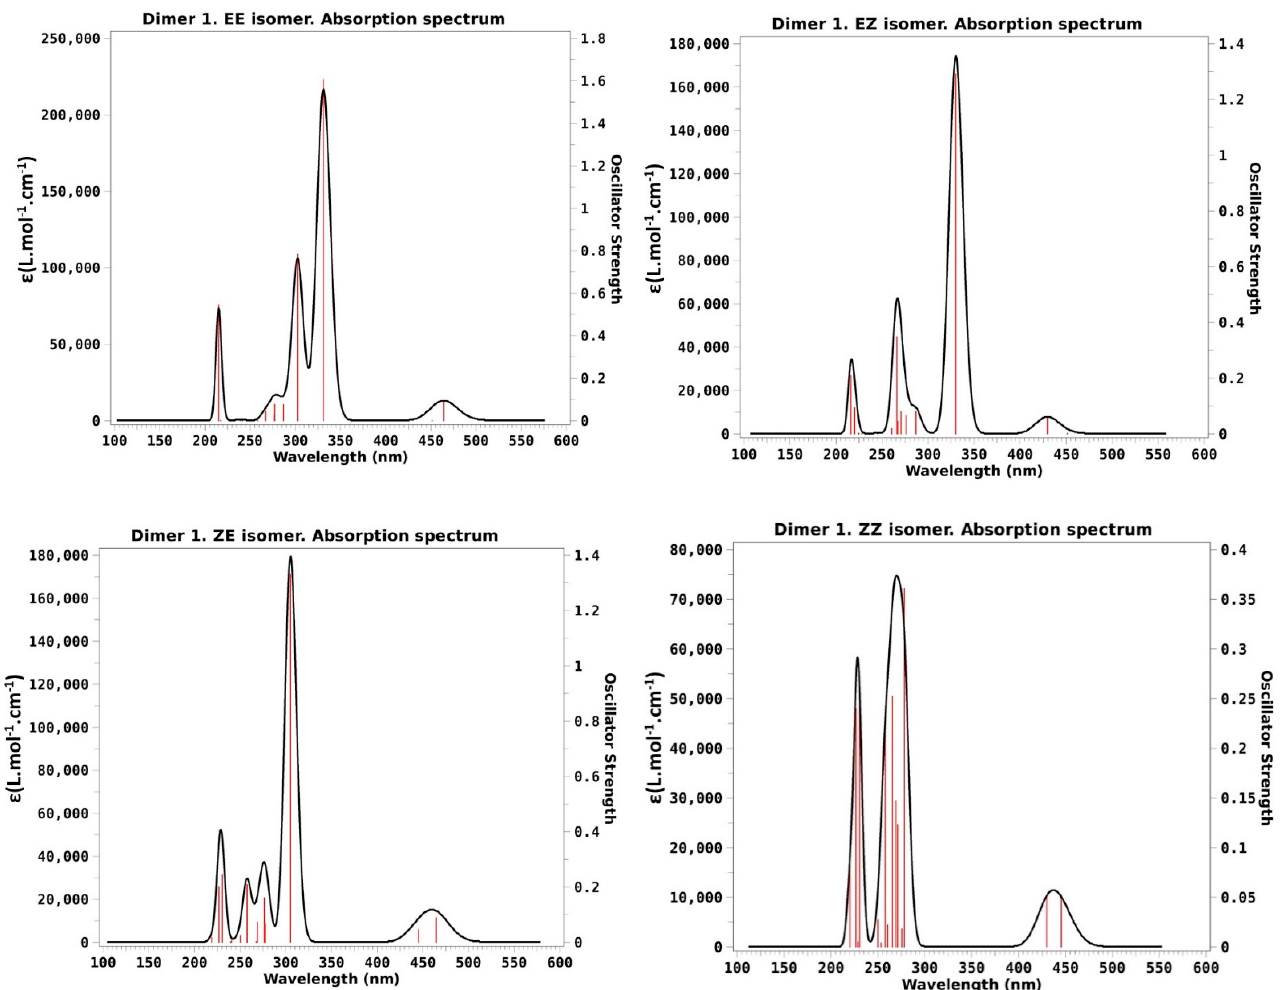
Figure 1. Computed absorption spectra of dimer 1 in acetonitrile at the optimized ground-state geometries of the four stable isomers of dimer 1. Vertical red lines indicate the position of the vertical transitions while the black contour corresponds to the convolution with a Lorentzian function depicted in order to theoretically reproduce the experimental absorption spectrum.